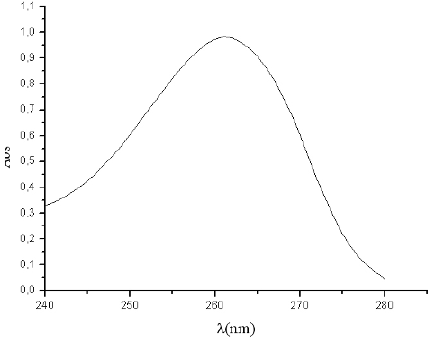
Figure 3. The absorbance of nicotinic acid solution 2.5×10 -4